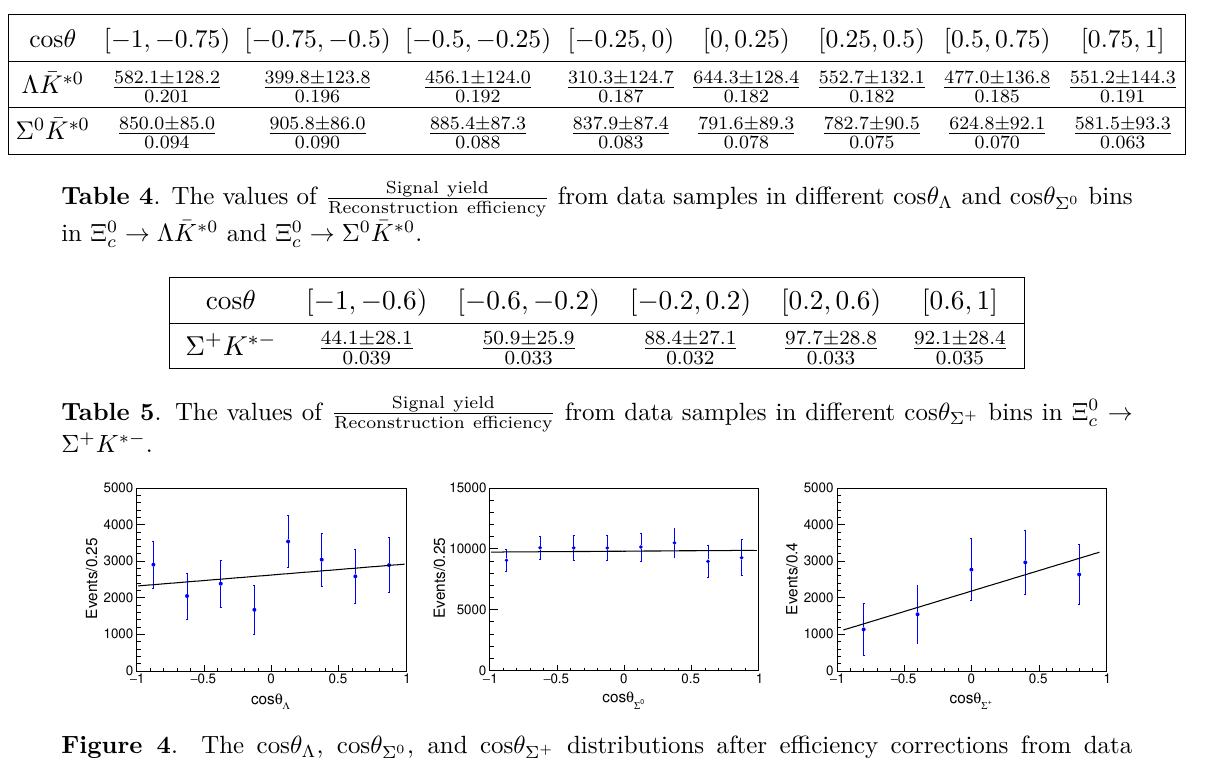
from data samples in different cos θ Λ and cos θ